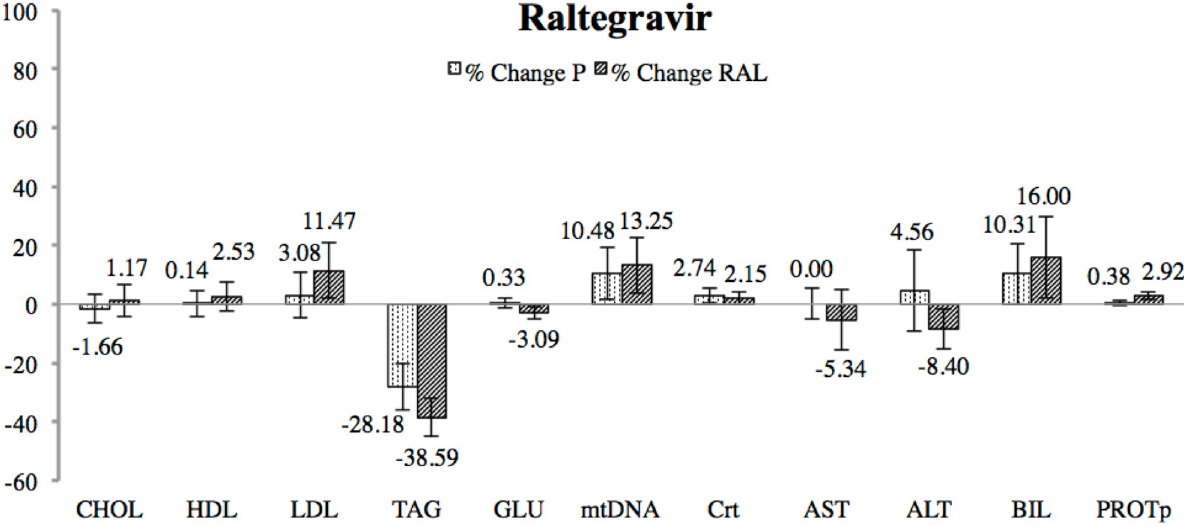
Fig 3. Percentage of change between final and baseline measurements for raltegravir (RAL) and placebo interventions. Significance was assessed through a Wilcoxon test. Variation is represented with error bars through the SEM value. No significant change was detected after T20